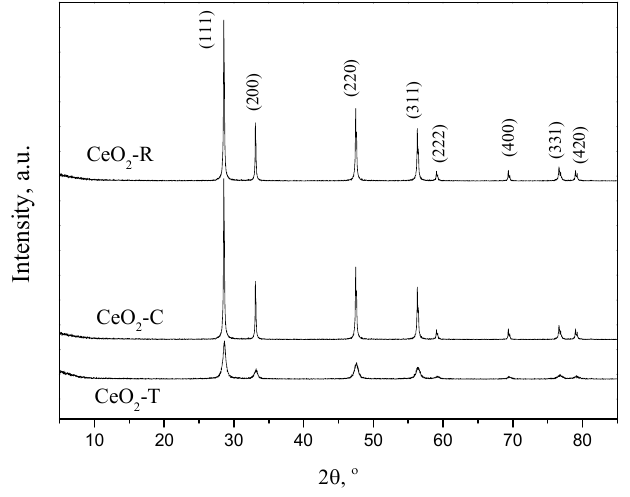
Figure 1. XRD patterns of CeO 2 with different morphologies.